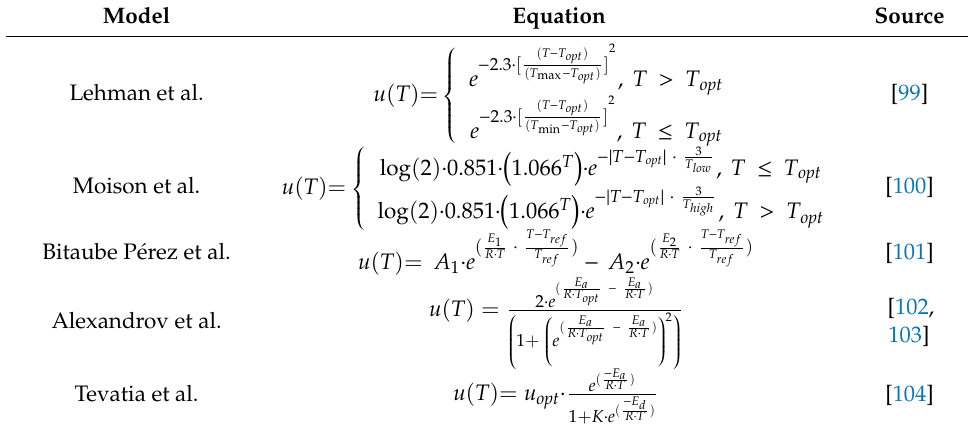
Table 1. Models describing a hunchback-shaped curve of temperature-dependent rates (not explained in the text). Model Equation Source Lehman et